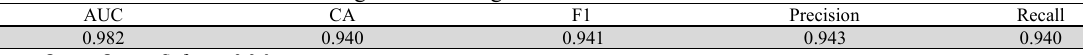
Test Results Validation of Tourist Village Status Using Decision Tree